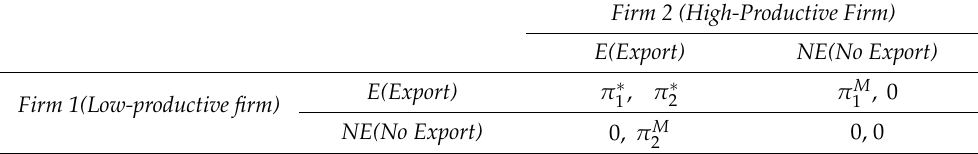
Table 1. Payoffs of the